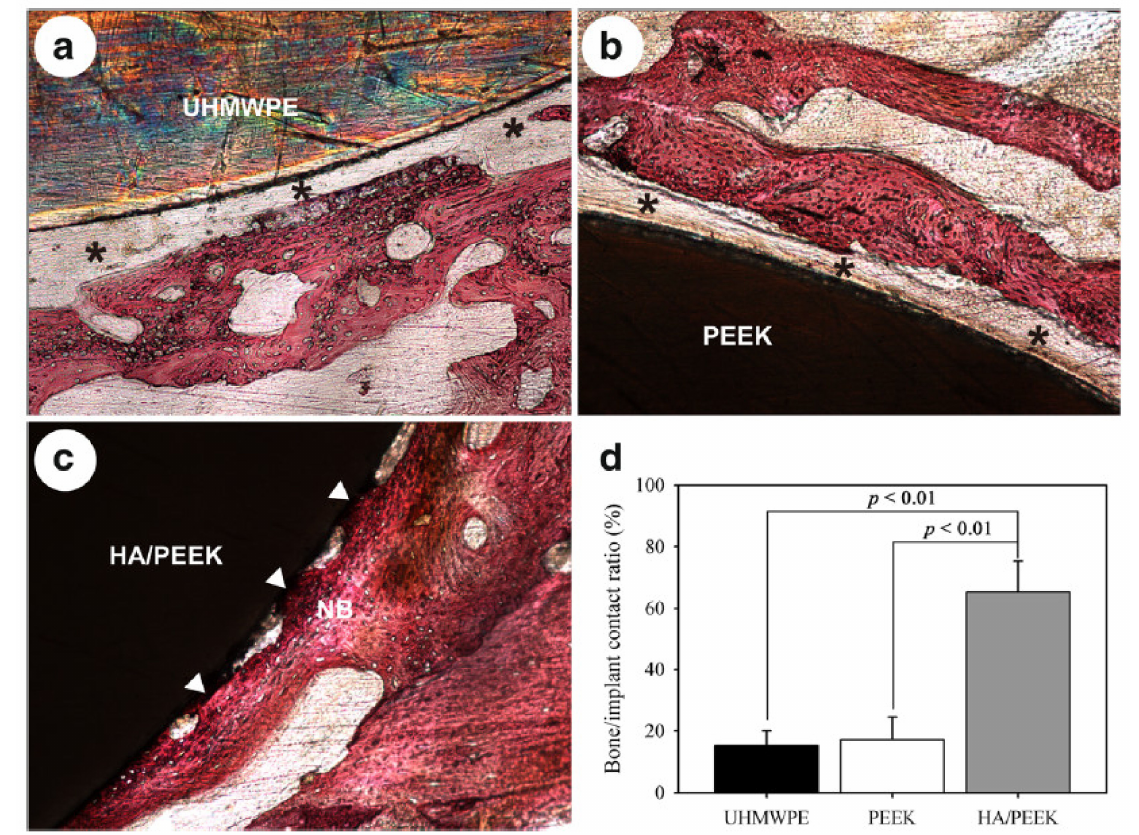
Figure 11. Histological observation after eight weeks of implantation in rabbits: ( a ) Ultra-high molecular weight polyethylene (UHMWPE), ( b ) PEEK, ( c ) HA/PEEK, ( d ) quantitative analysis of bone/implant contact ratio. The black asterisks indicate the fibrous connective tissue, and the white arrows indicate the bone contact. Printed with the permission of [116]. Copyright 2019, BioMed